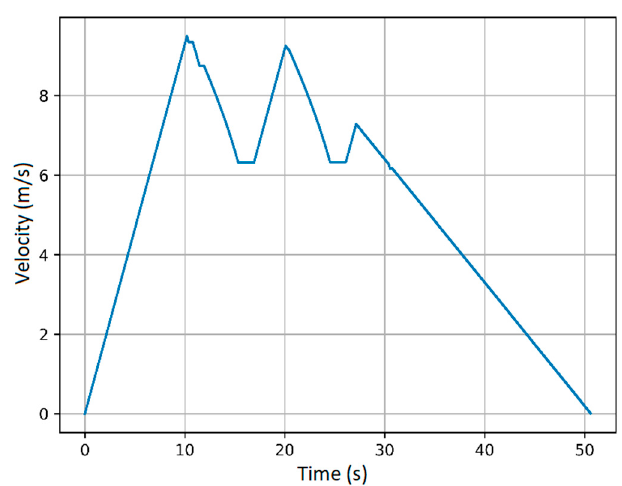
Figure 15. Velocity profile for the example path for the map 1.